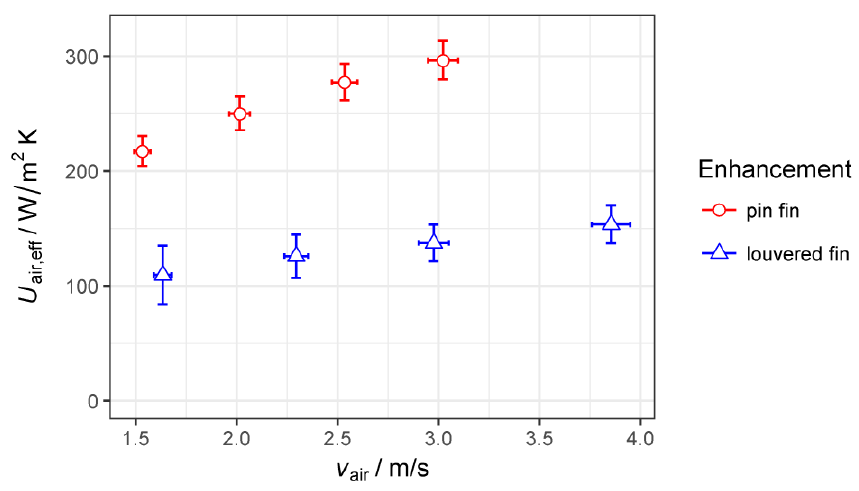
Figure 9. Effective heat transfer coefficient U air,eff versus air velocity v air for louvered and pin fins; error bars for expanded uncertainty.